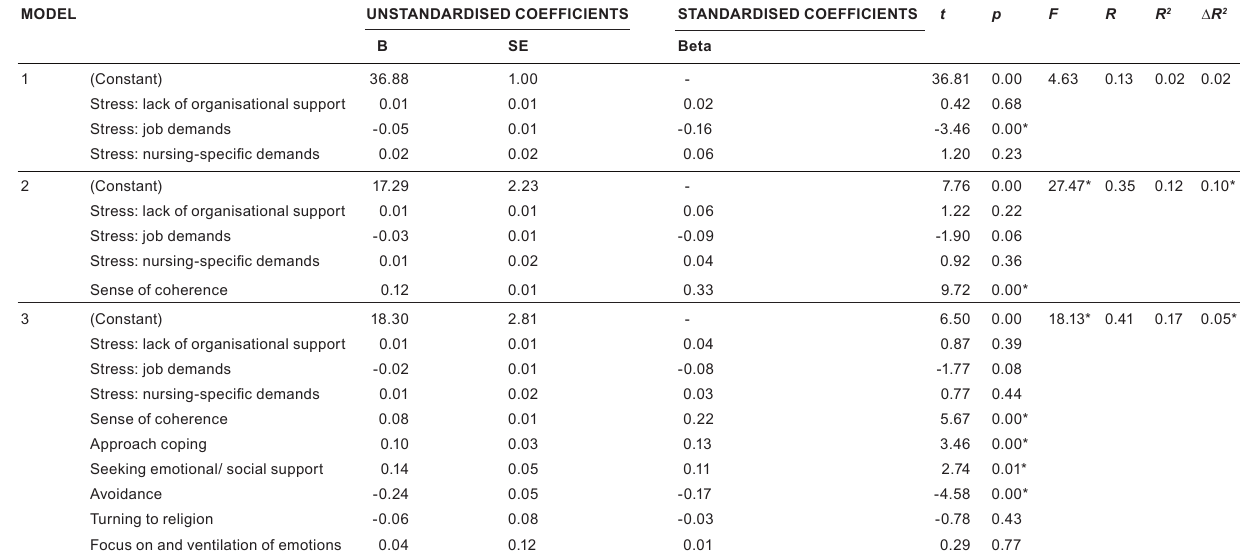
Multiple regression analysis with Personal Accomplishment as dependent variable and Occupational Stressors, Coping Strategies and Sense of Coherence as independent